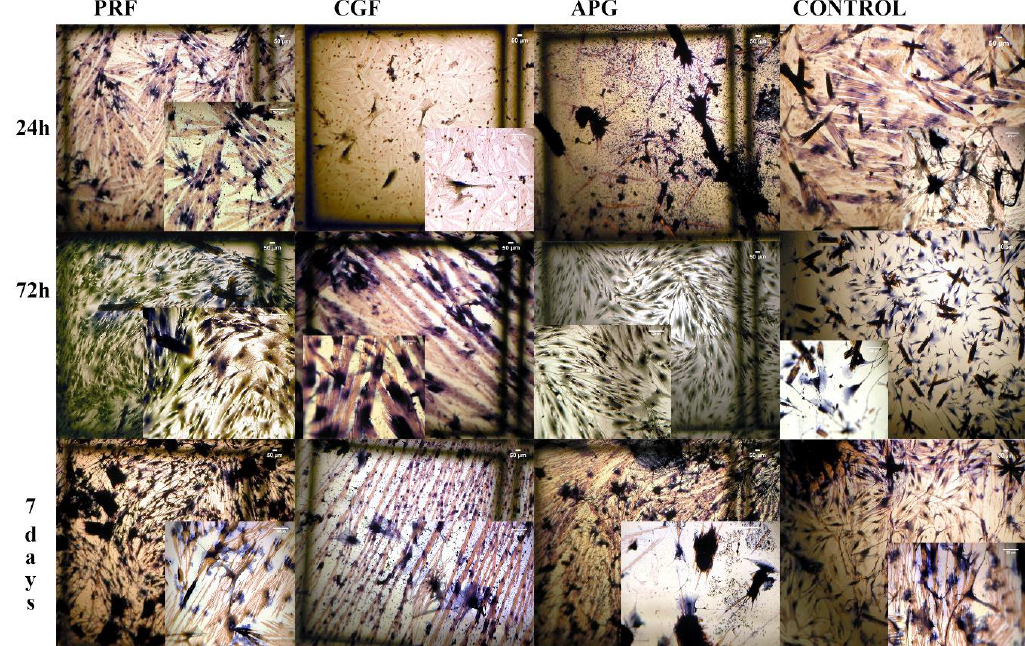
Figure 2. Light microscopy (LM) images of HPLF cells with the examined materials and the controls at the different examined times. The brown particles present are PBS salts. Azan Mallory staining. Magnification, 4x. When presented, the insets are at 10x magnification.